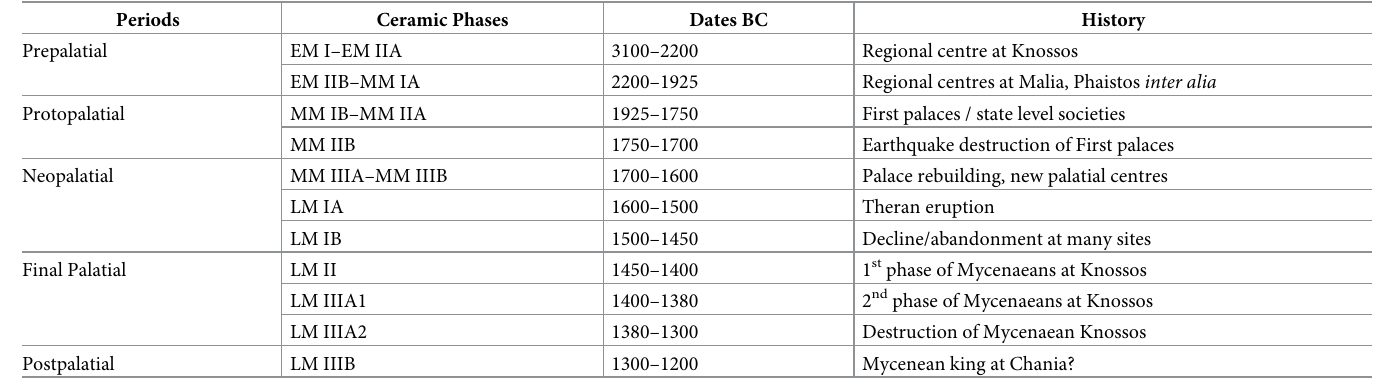
Table 1. Minoan chronology, phasing and major events. Based on [37, 43, 44].